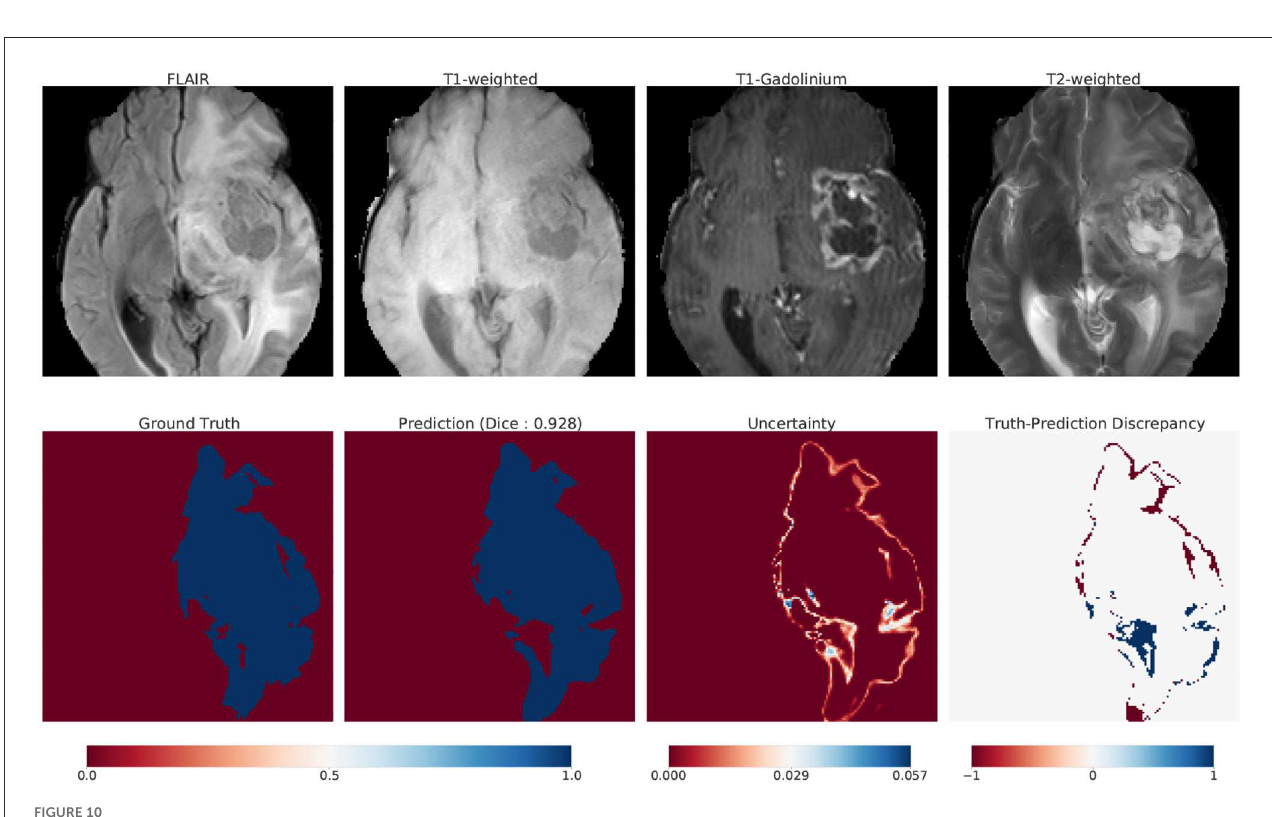
FIGURE10 Uncertainty map accompanying a prediction made by the pBNN.